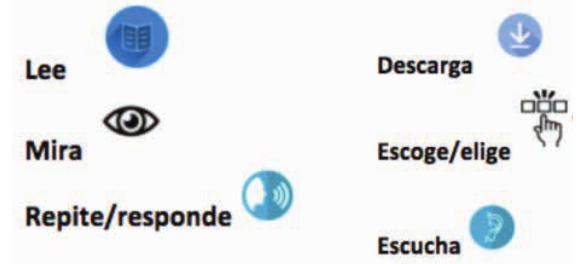
Figure 2: Icons used to support the instructions given in the courses Subtitles in Spanish and in the most common languages among the refugees and migrants interested in Spain and Spanish (namely, English, French and Arabic) were created. All the videos in the courses (e.g., about the structure, how to navigate around the platform, how to carry out activities, etc.) had subtitles in those languages (as well as transcriptions in PDFs ready for